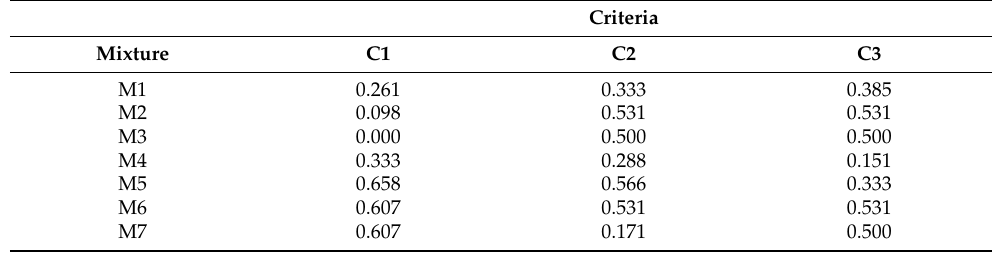
Table A2. Complete matrix S’ ij for the MEREC